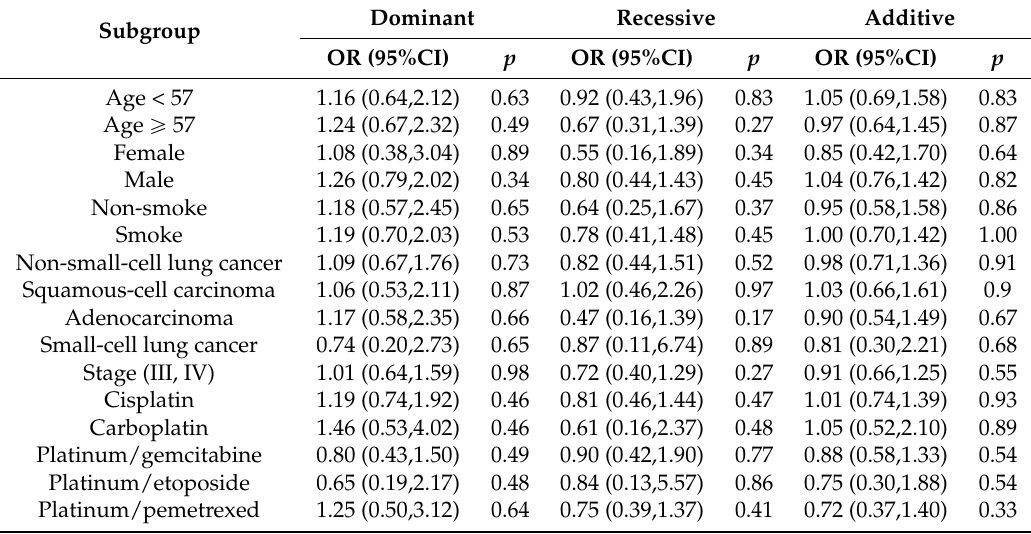
Table 12. Stratification analysis of relationship between CASC8 rs10505477 and overall severe toxicity induced by platinum-based chemotherapy in lung